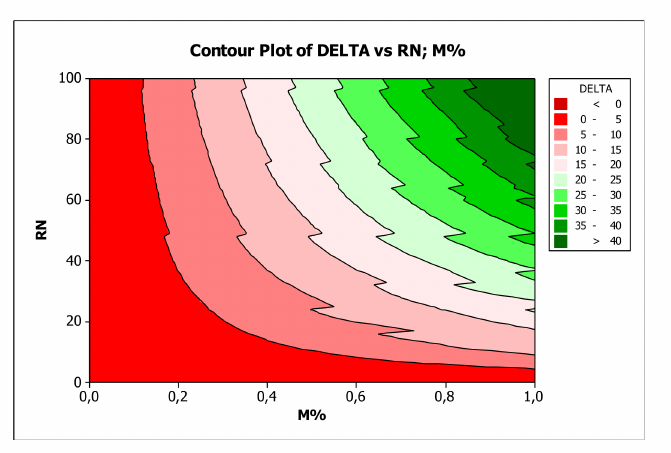
Figure 11. DELTA trend toward M% and